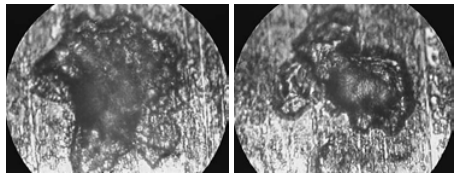
Fig7. Surface appearance in the initial stage of coating precipitation ( · 290)